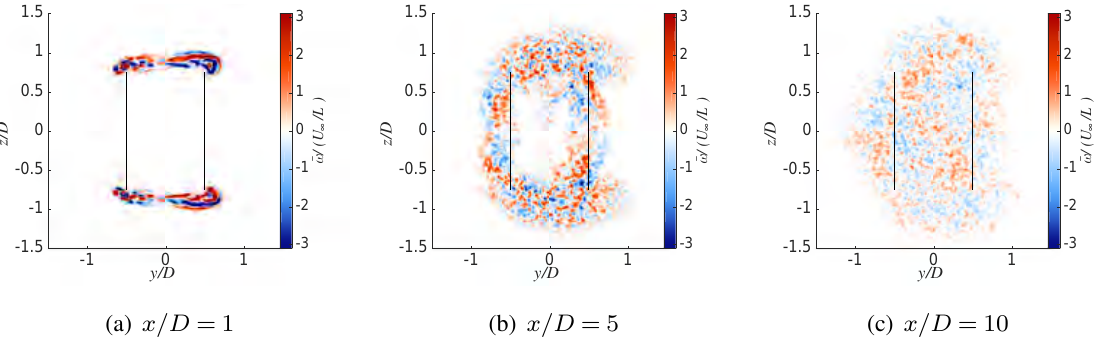
Figure 9. H-type VAWT with AR = 1 . 5: mean streamwise vorticity ¯ ω/ ( U ∞ /L ).